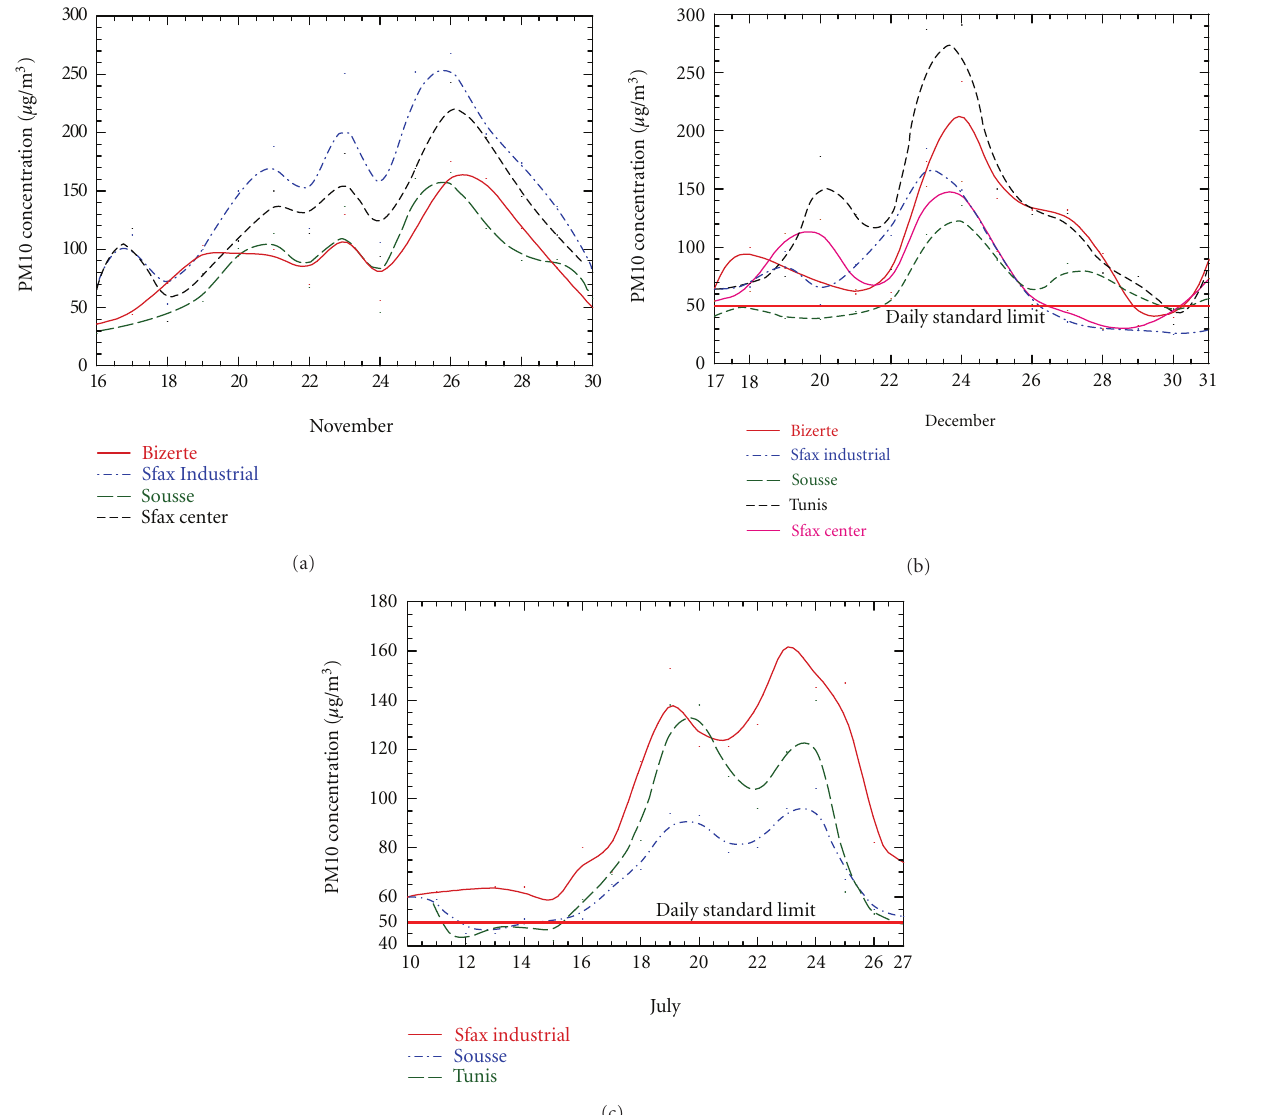
Figure 5: Concurrent daily PM10 average concentrations recorded at the selected monitoring stations over the study period along with identified exceeded values. (Solid and dashed lines are smooth curve